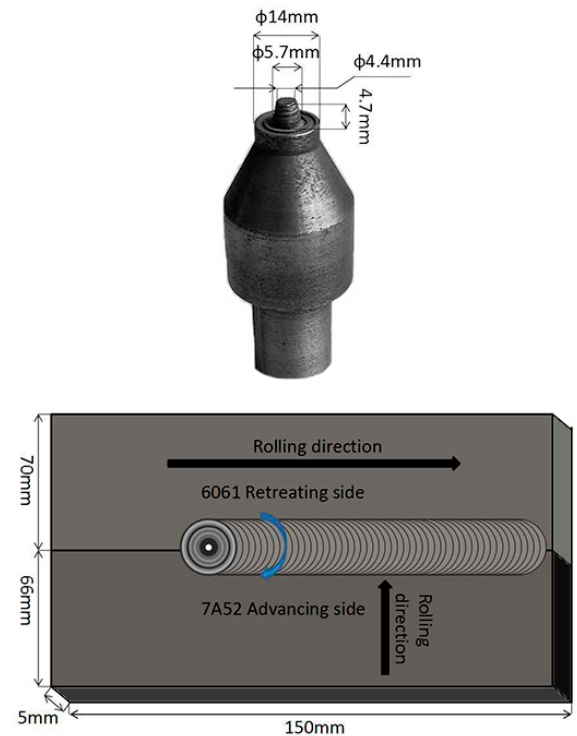
Figure 1. Schematic illustration of the friction stir butt welding of 7A52/6061 dissimilar Al alloys and an image of actual friction stir welding (FSW) tool used in all